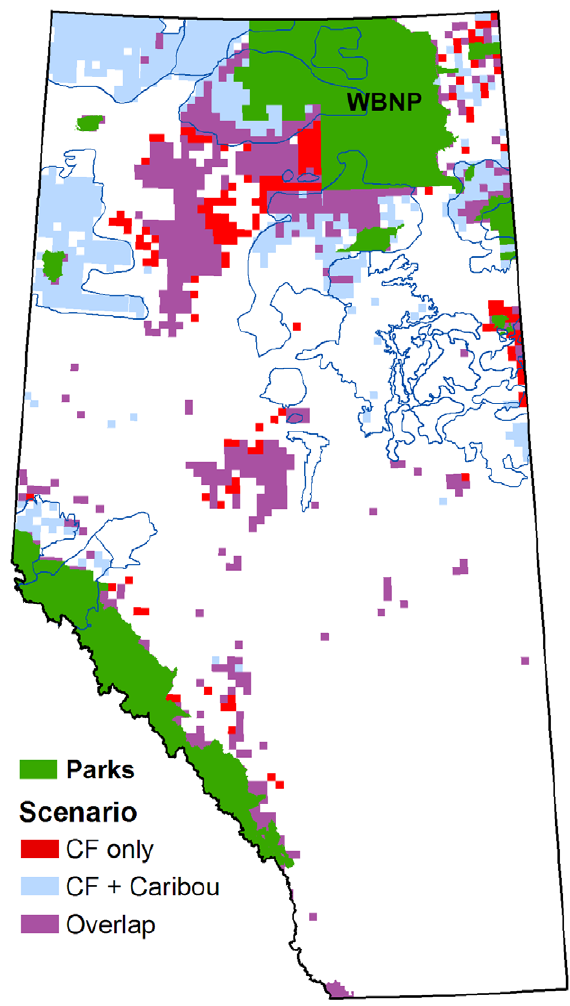
Figure 7. Planning units selected in Scenario 3. Units labelled CF (red) were selected in a model that included only coarse-filter targets (at 20%). Units in blue were selected in a model that also included a caribou protection target of 60%. Units labelled ‘‘Overlap’’ (purple) were selected by both models.